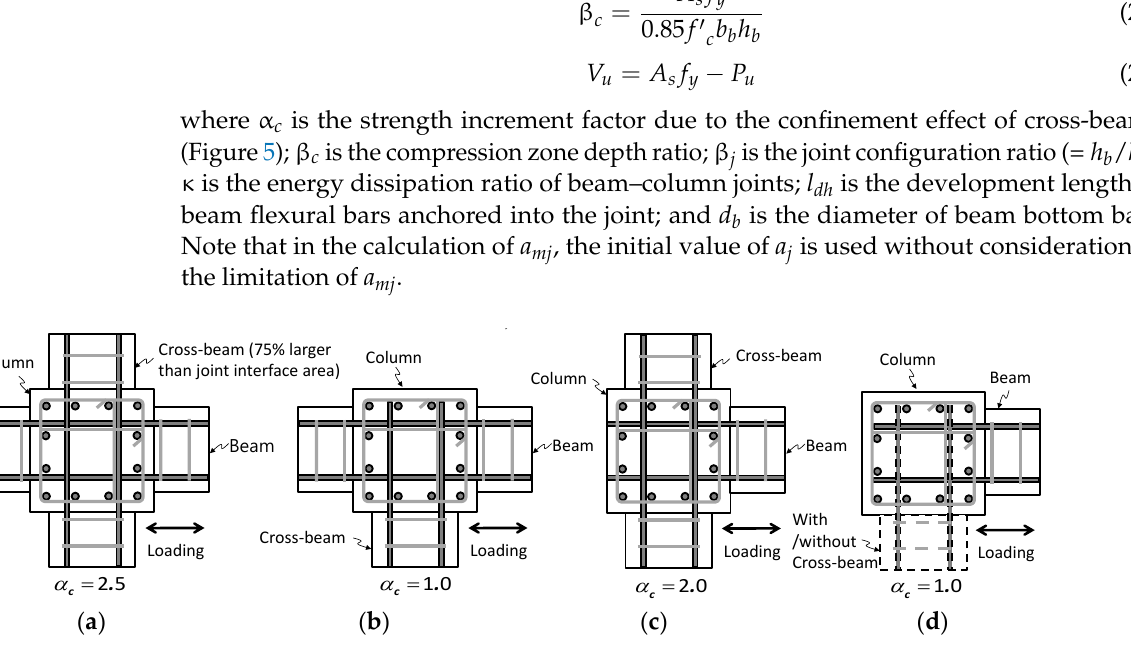
Figure 5. Confinement of beam–column joints: ( a ) interior beam–column joint with two-cross beams; ( b ) interior beam–column joint without two-cross beams; ( c ) exterior beam–column joint with two-cross beams; ( d ) exterior beam–column joint without two-cross beams.